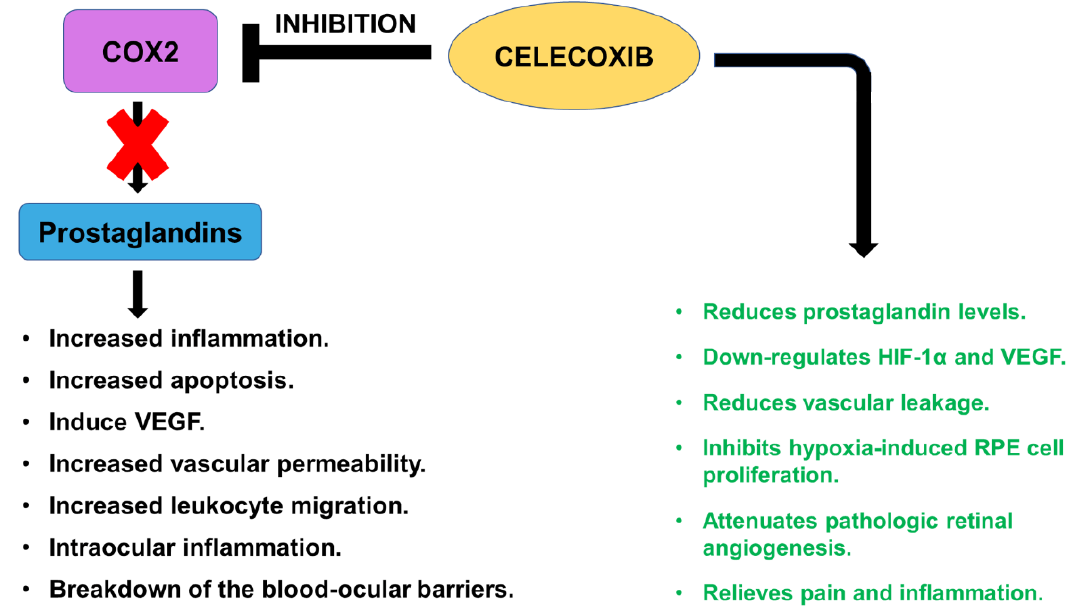
Figure 5. Celecoxib’s mechanism of action. Celecoxib inhibits COX2 (Cyclooxygenase-2) and prevents the pro-apoptotic and pro-inflammatory action of prostaglandins. Celecoxib reduces prostaglandin levels, down-regulates HIF-1 α and VEGF, reduces vascular leakage, inhibits hypoxia-induced RPE cell proliferation, attenuates pathologic retinal angiogenesis, and relieves pain and inflammation.